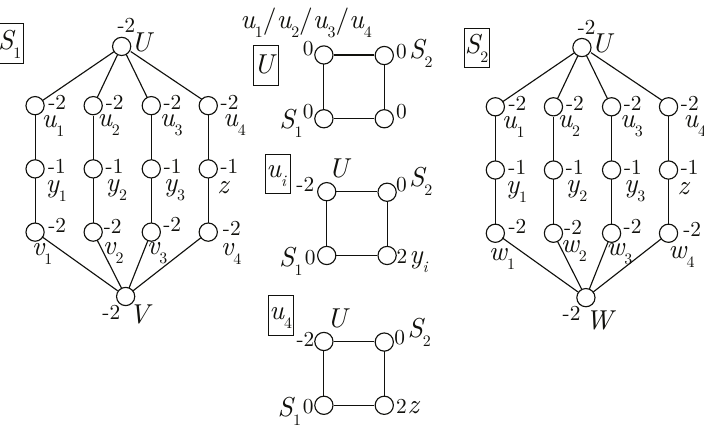
Figure 4. The con(cid:12)guration of curves on the seven compact surfaces ( U; u 1 ; u 2 ; u 3 ; u 4 ; S 1 ; S 2 ) in the resolution geometry of (SO(8) ; SO(8)) N = 2 non-minimal conformal matter theory. Here u i denotes u 1 , u 2 and u 3 , which has the topology of Hirzebruch surface F 2 .